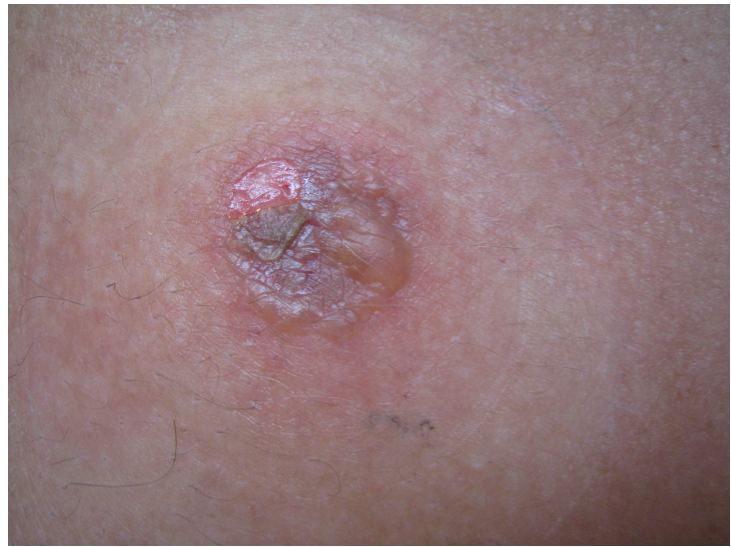
FIGURE 1 . Blistering and ulceration secondary to irritative contact between the skin and the delivery mechanism of the drug on the patch. The adhesive at the edge of the spherical patch may be made out in the upper part of the